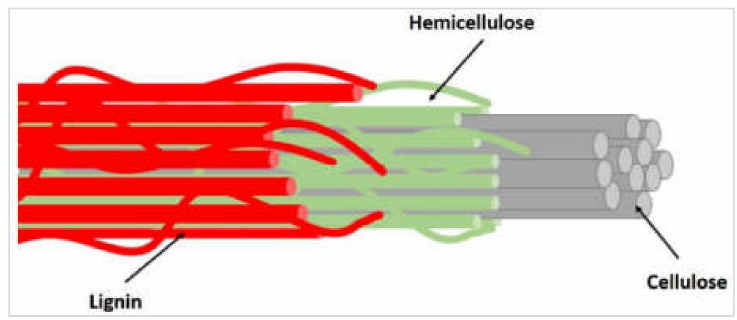
Figure 9. Natural lignocellulosic fiber